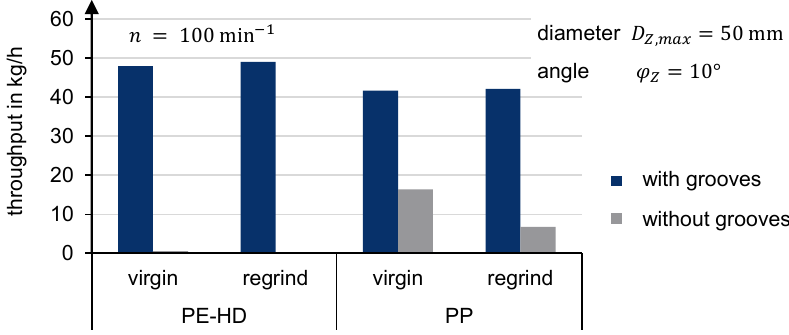
Figure 16. Experimental throughput depending on grooves in the compression zone.